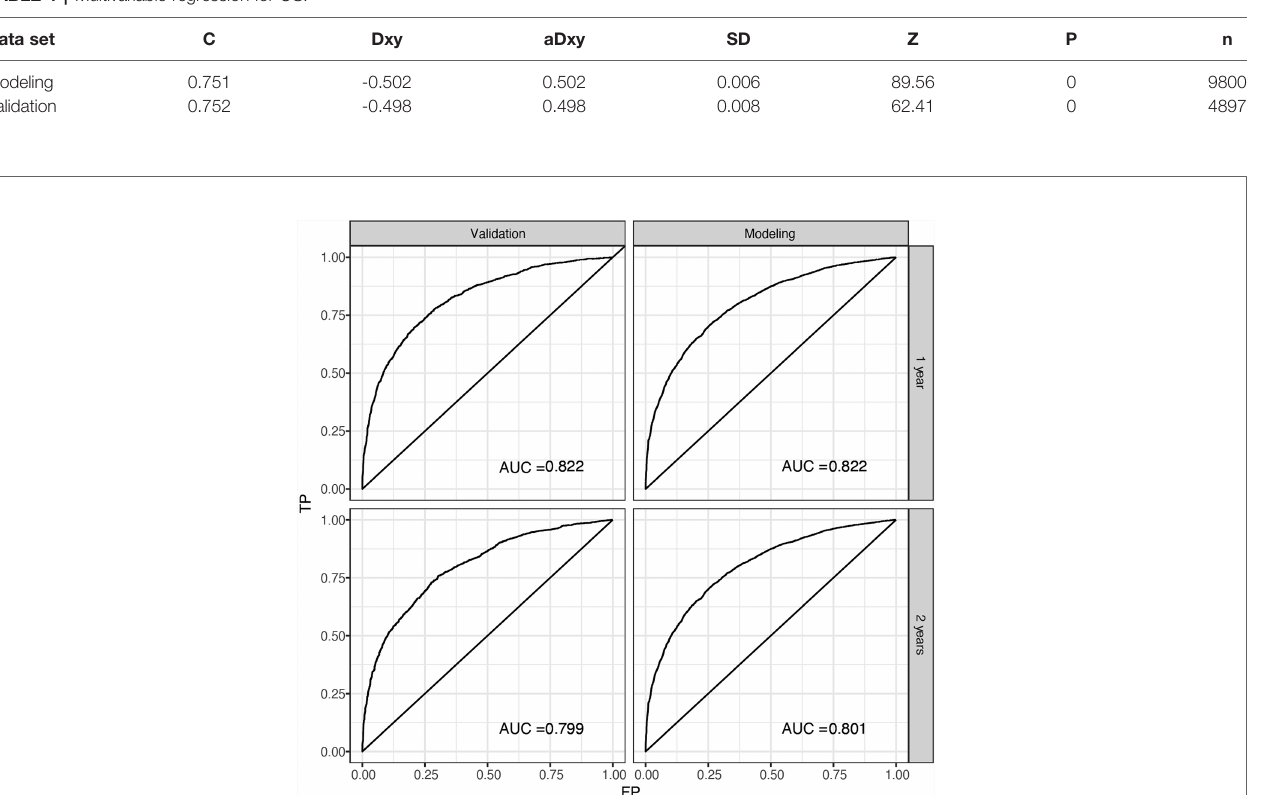
TABLE 4 | Multivariable regression for OS.